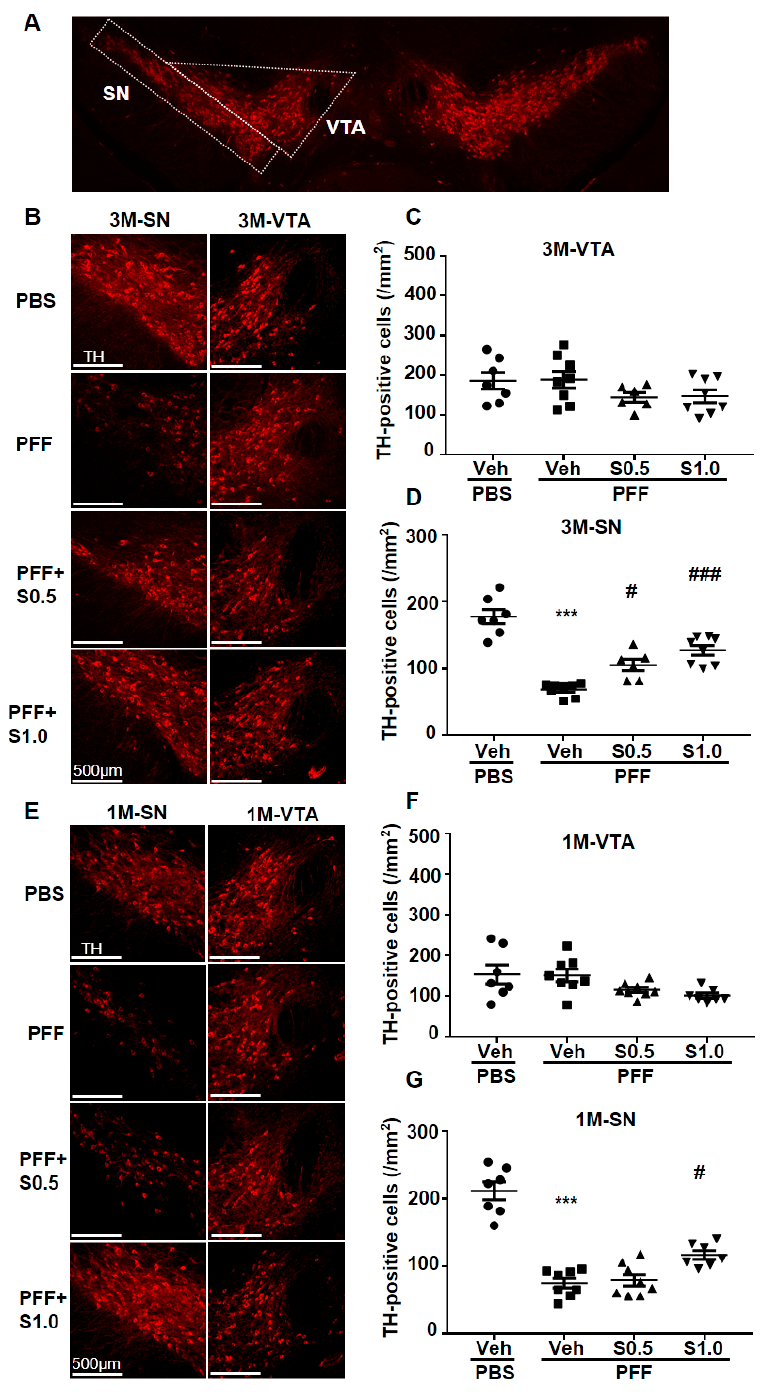
Figure 4. SAK3 treatment prevents the dopaminergic neuronal death in the SN but not in the VTA of PFF-injected mice. ( A ) The VTA and SNc region are framed by a white line. ( B ) The representative immunofluorescence images of TH in the VTA and SNc regions during the 3-month SAK3 treatment schedule. Scale bar: 500 µ m. The number of TH-positive cells was counted in the ( C ) VTA and ( D ) SNc region ( n = 6–8 per group). ( E ) The representative immunofluorescence images of TH in the VTA and SNc region during the 1-month SAK3 treatment schedule. Scale bar: 500 µ m. The number of TH-positive cells was counted in the ( F ) VTA and ( G ) SNc region ( n = 7–8 per group). Error bars represent SEM. *** p < 0.001 vs. vehicle-treated PBS-injected mice; # p < 0.05, ### p < 0.001 vs. vehicle-treated α -Syn PFF-injected mice. Abbreviations: Veh = vehicle; S =